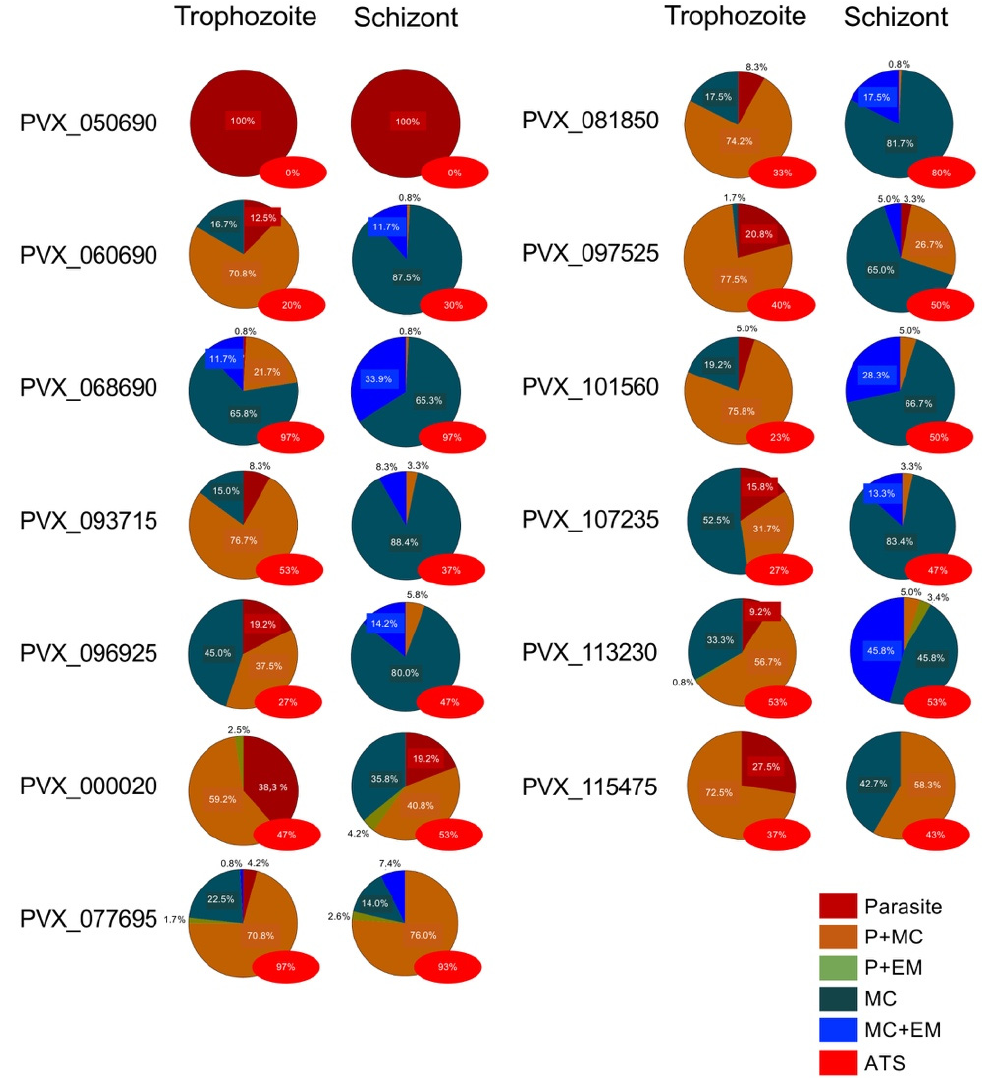
Figure 3. Localization of VIR proteins in erythrocytes infected with vir -expressing P. falciparum 3D7 transfectants (P: Parasite (dark red), P + MC: Parasite and Maurer’s clefts (orange), P + EM: Parasite and erythrocyte membrane (green), MC: Maurer’s clefts (dark green), MC + EM: Maurer’s clefts and erythrocyte membrane (blue), ATS: Acidic terminal segment of Pf EMP1 (red)). For each stage of development (trophozoite and schizont), 120 Pf IEs per transfectant were